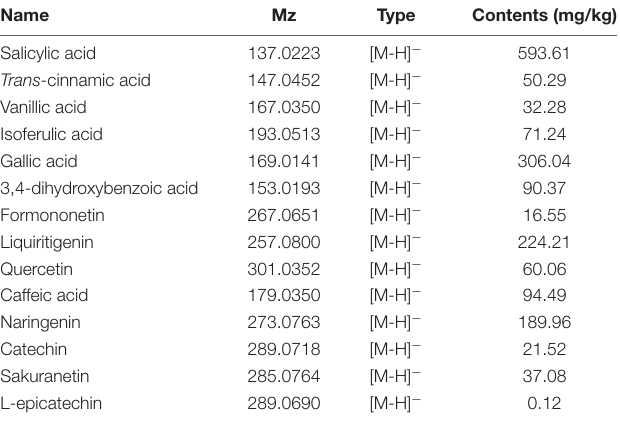
TABLE 2 | LC-MS characterization of fourteen polyphenols in P. vicina